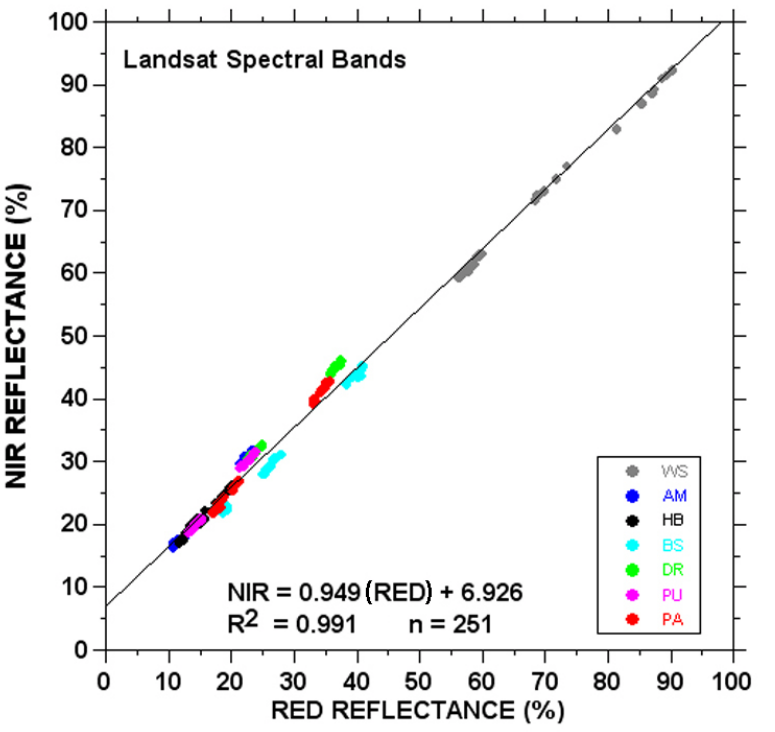
Figure 7. NIR versus red reflectance for the seven soils used in this study (refer to Table 1 for meanings of the symbols representing the soil names). Diagonal line passing through the points is the least-squares